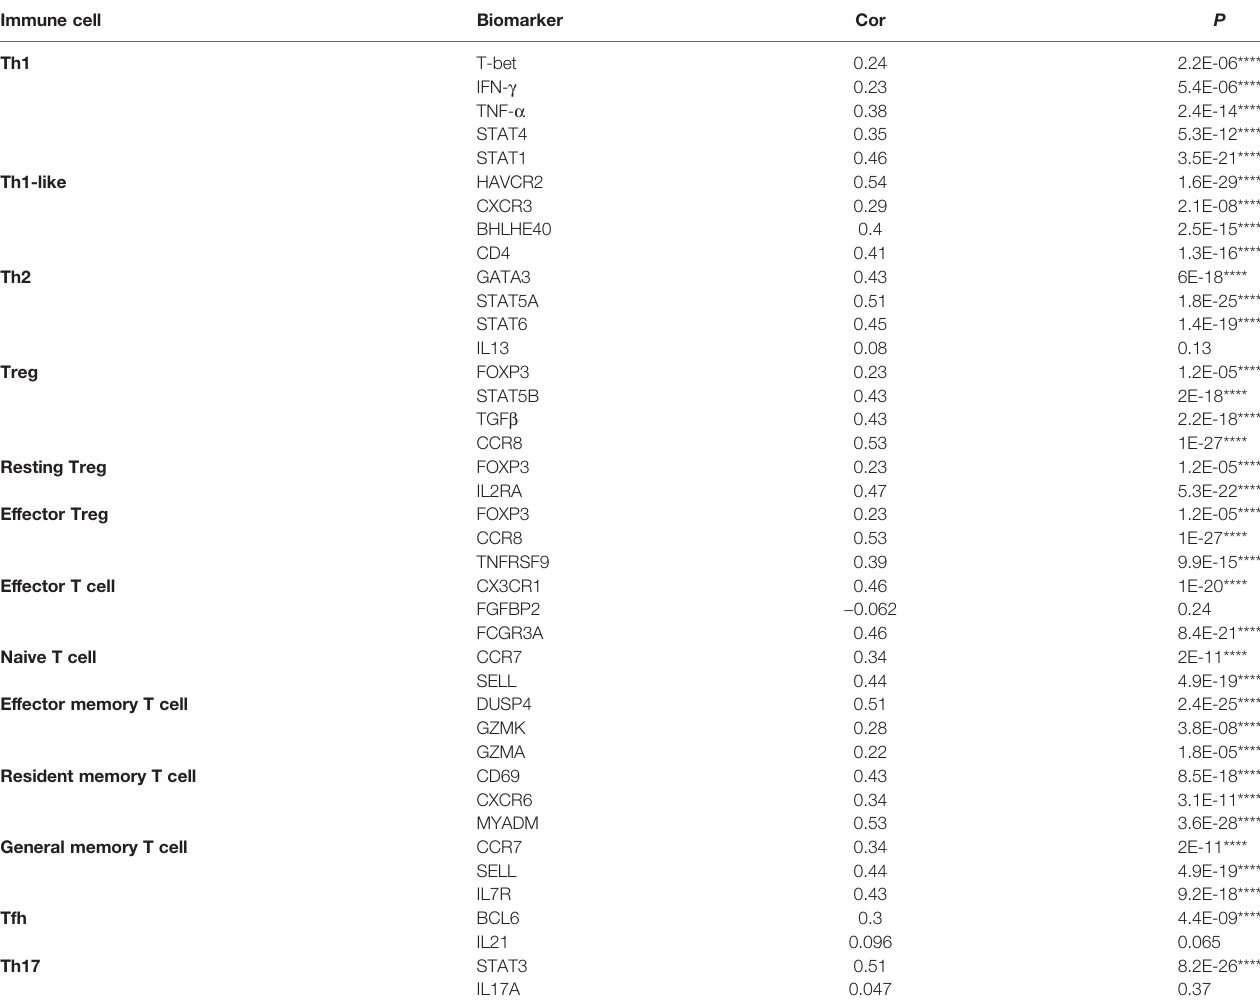
TABLE 3-2 | Correlation analysis between EOGT and biomarkers of T cells in HCC in GEPIA2. Immune